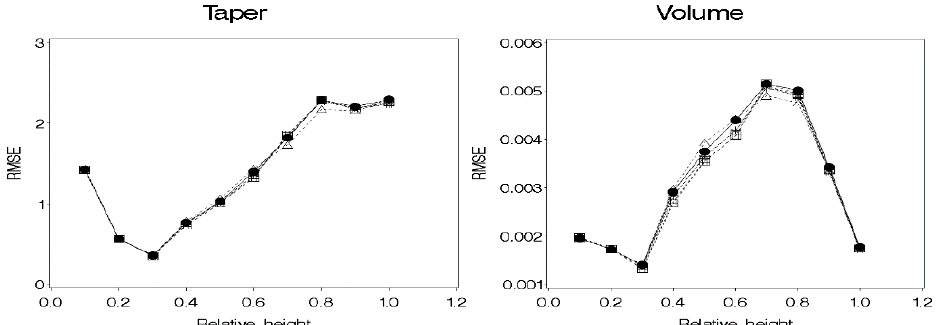
Figure 4. Root mean square error (RMSE) by relative height classes for diameter and volume predictions using Clark model with and without crown variables for Manchurian fir. (For Figures 2–4: Symbols for Clark model with and without variables; Clark (dot), crown length (CL) (star), crown ratio (CR) (hash), crown width (CW) (circle), diameter at crown base (CD) (triangle), height to live crown base (HCB) (square) and crown shape (CS) (plus).